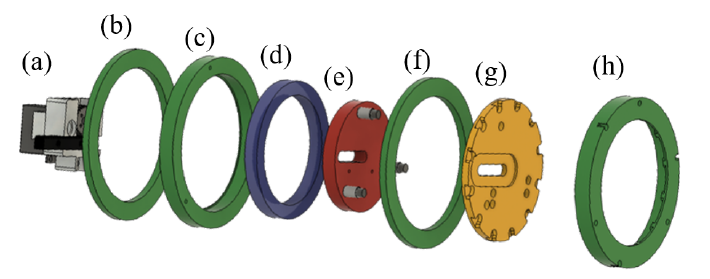
Figure 7. Assembly details on wheel module (( a ) rack-and-pinion unit, ( b ) outer ring (side of rack- and-pinion unit), ( c ) outer ring (around bearing), ( d ) bearing, ( e ) inner ring, ( f ) outer ring, ( g ) clutch disk, and ( h )